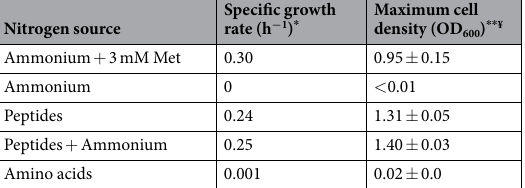
Table 1. Effect of different nitrogen sources on growth of P. ruminicola strain 23. ( * ) Number of generations per unit time during exponential growth. ( ** ) Maximum optical density values after 38 hours culture. (¥) Average values from three technical